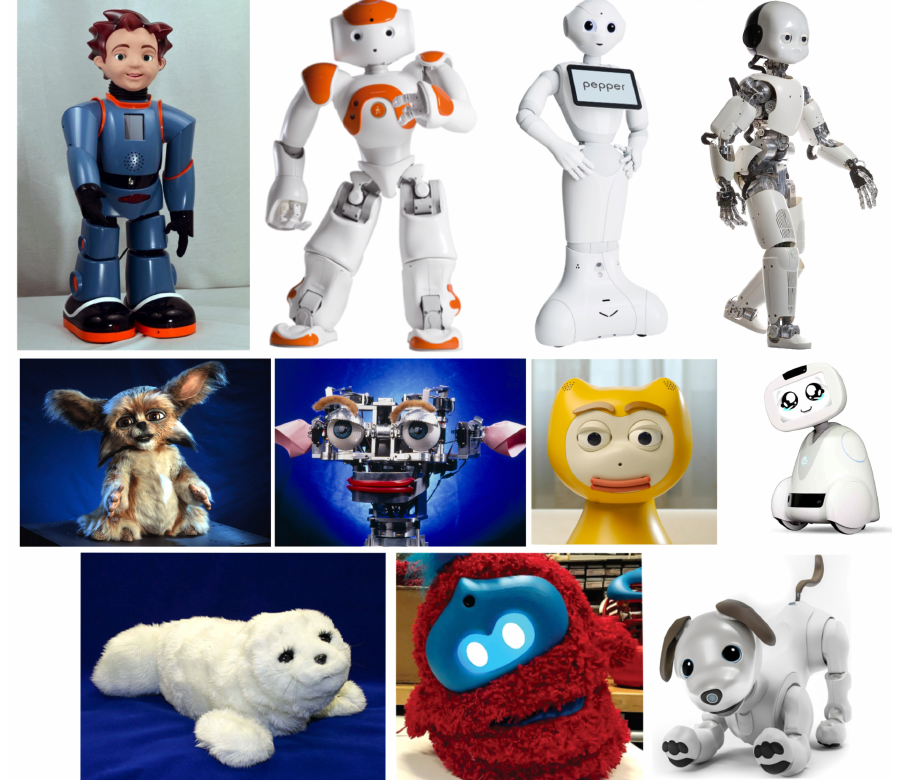
Figure 2. Robot companions. Humanoids in top row—from left to right (1) Zeno (Hanson Robotics), (2) NAO (Aldebaran Robotics), (3) Pepper (Aldebaran Robotics), (4) iCub (Italian Institute of Technology); Middle row—from left to right (1) Leonardo (MIT), (2) Kismet (MIT), (3) iCat (Philips), (4) Buddy (Blue Frog Robotics); Bottom row—from left to right (1) Paro (AIST), (2) TEGA (MIT), (3) New AIBO